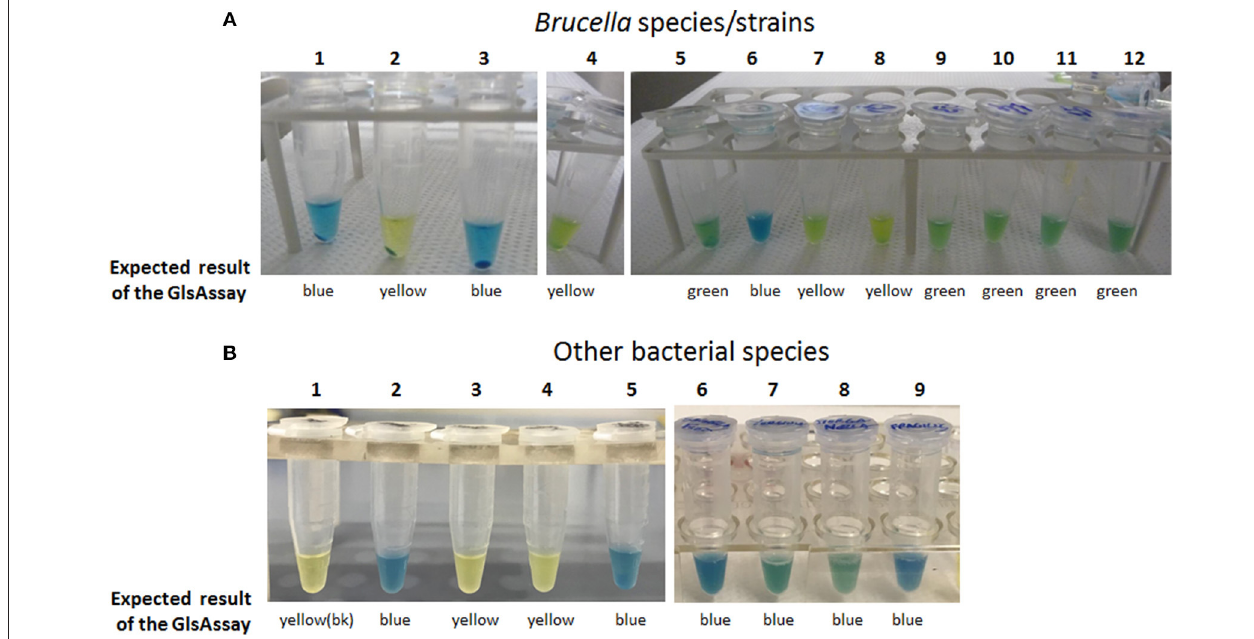
FIGURE 6 | The GlsAssay tested on different bacterial species/strains. (A) The GlsAssay was performed starting form colonies on TS plate of the following Brucella species/strains: (1) B. microti CCM4915 (wild type), (2) B. microti CCM4915 1 glsA , (3) B. microti CCM4915 1 glsA carrying plasmid pBBR- glsA _ Bm , (4) B. abortus ATCC23448 (wild type), (5) B. abortus ATCC23448 carrying plasmid pBBR- glsA _ Bm, (6) B. inopinata BO1, (7) B. melitensis 16M, (8) B. ovis ATCC25840, (9) B. neotomae 5K33, (10) B. suis 1330, (11) B. suis S4, (12) B. canis RM16/66. (B) The GlsAssay was performed starting form liquid cultures (picture on the left) or from colonies (picture on the right) of the following bacterial species : (1) GlsAssay solution (blank), (2) E. coli MG1655 wild type, (3) E. coli 1 ybaS , (4) Salmonella typhimurium LT2, (5) Yersinia ruckeri ATCC29473, (6) Shigella flexneri CIP52.36, (7) Yersinia enterocolitica , (8) Morganella morganii morganii CIP A236, (9) Bacteroides fragilis CIP77.16. The incubation was carried out at 37 ◦ C for